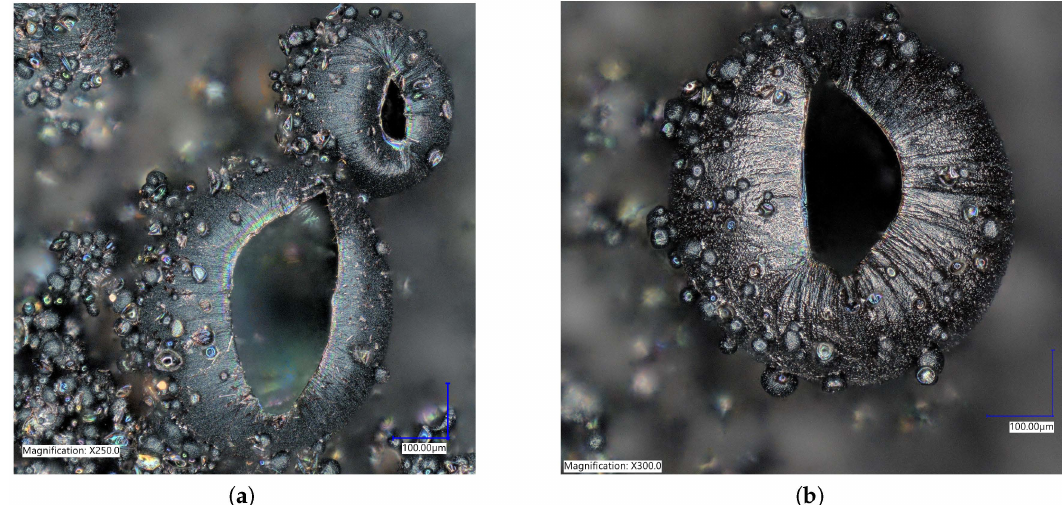
Figure 4. Optical microscopy pictures at ( a ) × 250 and ( b ) × 300 of polypyrrole films created using bent electrodes. These shows the stacked and hierarchical structures that increased the ion doping sites for increased doping capacity.